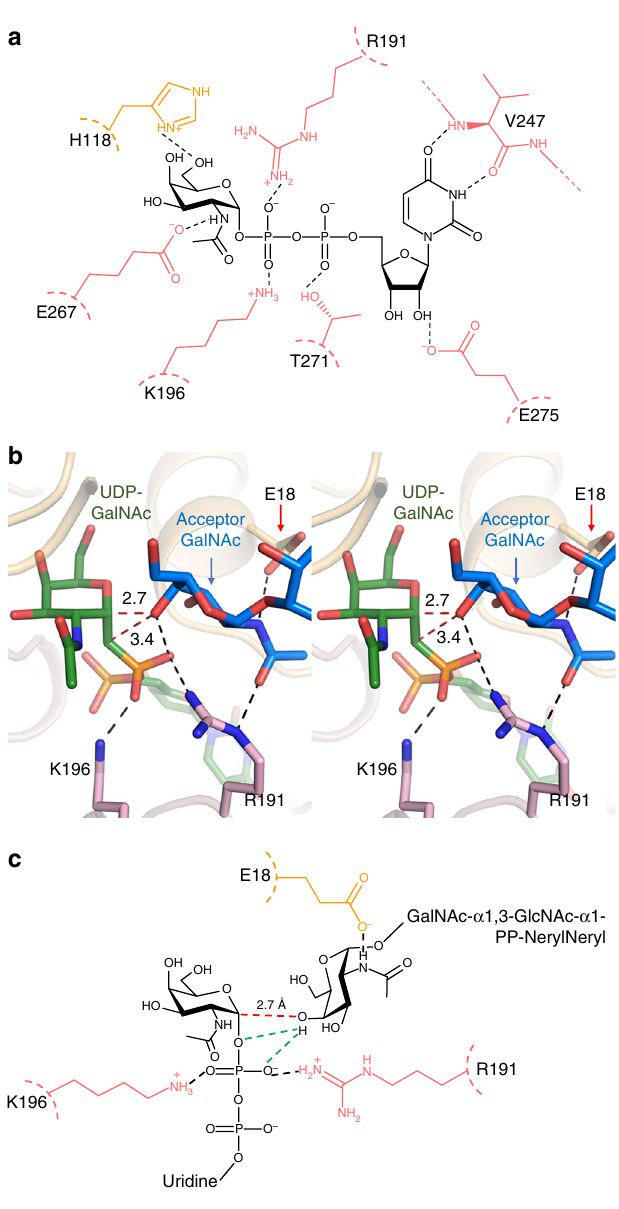
Fig. 3 Binding of substrates at the catalytic site. a Interactions of PglH with the donor substrate UDP-GalNAc. Side chains of the C-terminal and N- terminal domains are colored pink or orange, respectively, and labeled in single-letter code. Black dashed lines indicate hydrogen bonds. b Stereo view of the catalytic site of PglH bound to LLO analog and UDP-CH 2 - GalNAc. Acceptor and donor substrates are shown as blue and green sticks and labeled. PglH residues essential for function are shown as sticks and labeled. Black, dashed lines represent interactions between PglH and bound substrates. Red dashed lines indicate distances between the C4 hydroxyl of the acceptor GalNAc and the anomeric carbon or the methylene group from the phosphonate group. c Schematic of the interactions between PglH and donor and acceptor substrates in the catalytic site. A red dashed line indicates the distance between the C4 hydroxyl of the acceptor substrate and the anomeric carbon of the donor substrate. Black dashed lines represent interactions between PglH and the substrates. Green dashed lines represent two possible, but mutually exclusive hydrogen